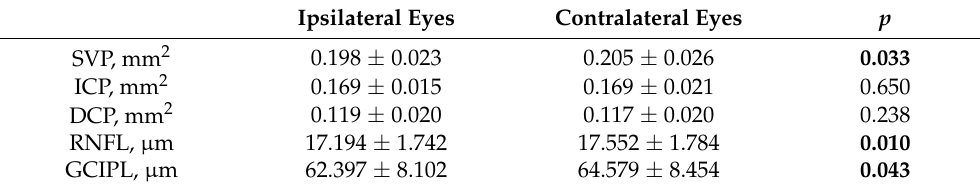
Table 3. Comparison of SS-OCT/SS-OCTA parameters between ipsilateral and contralateral eyes. Ipsilateral Eyes Contralateral Eyes p SVP, mm 2 0.198 ± 0.023 0.205 ± 0.026 0.033 ICP, mm 2 0.169 ± 0.015 0.169 ± 0.021 0.650 DCP, mm 2 0.119 ± 0.020 0.117 ± 0.020 0.238 RNFL, µ m 17.194 ± 1.742 17.552 ± 1.784 0.010 GCIPL, µ m 62.397 ± 8.102 64.579 ± 8.454